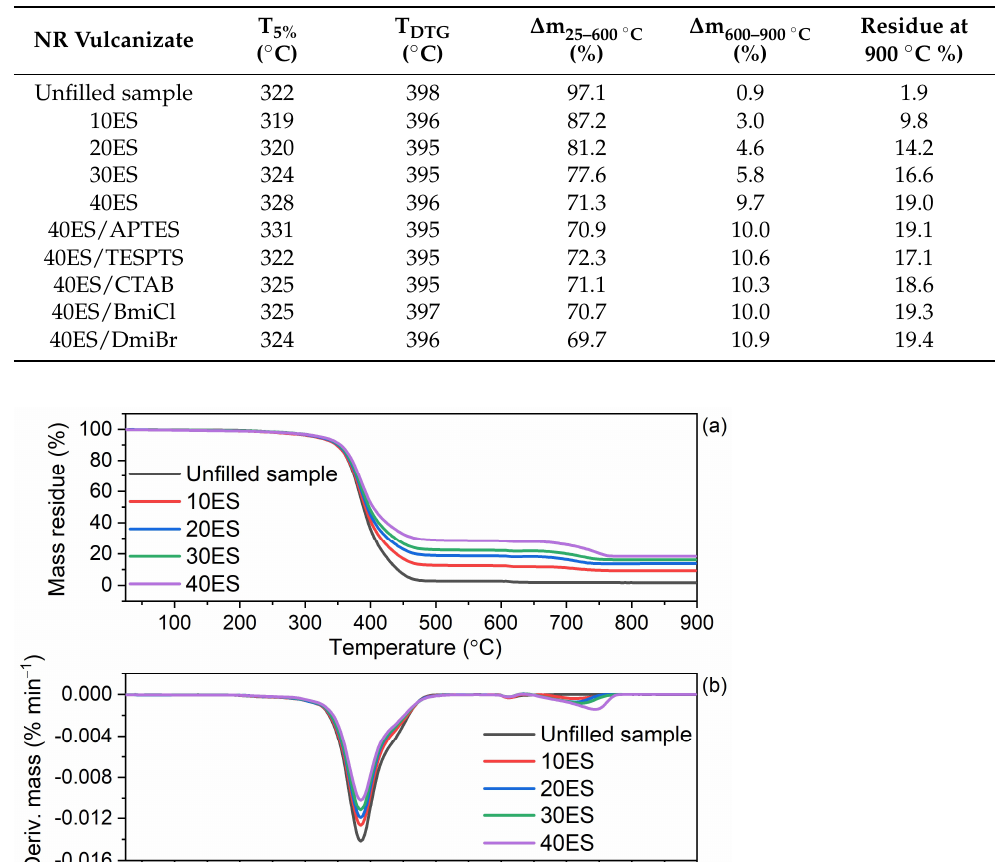
Table 9. Onset temperature of thermal decomposition (T 5% ), DTG peak temperature (T DTG ), and